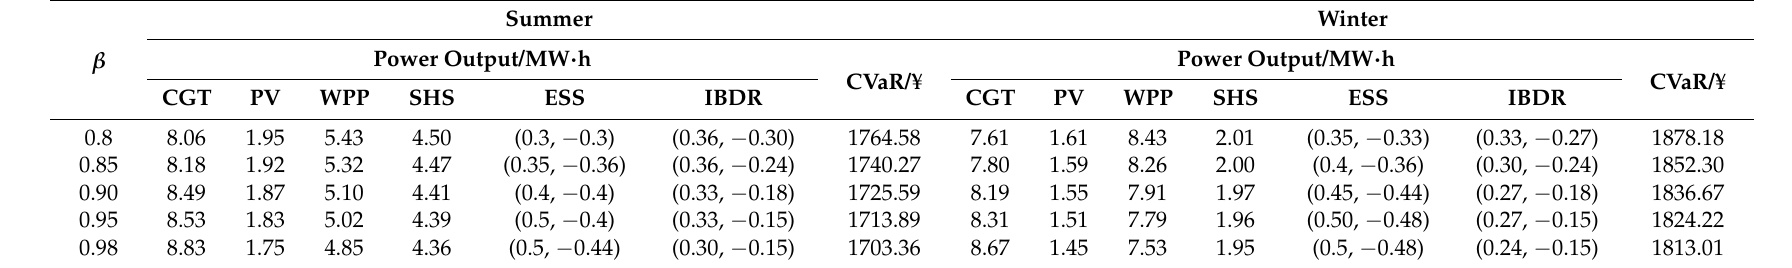
Table 3. Scheduling results of VPP operation under different confidence degrees β